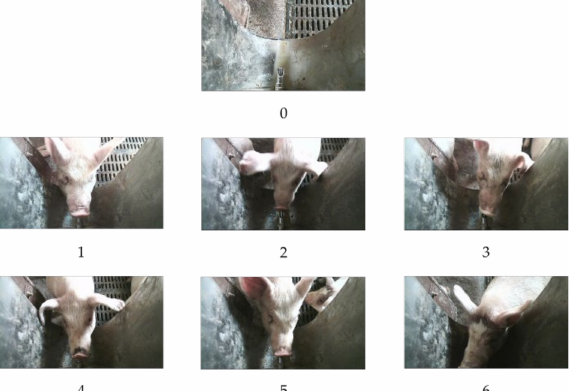
Figure 6. Images of individual pigs at DARS. Nondrinking ( 0 ); numbers of drinking pigs ( 1 ~ 6